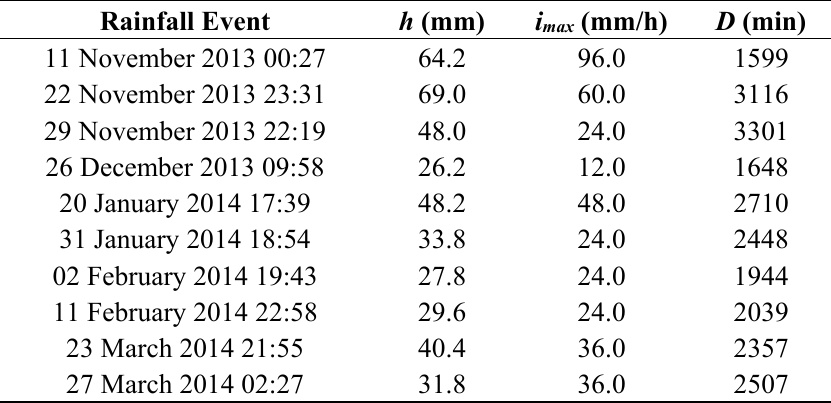
Table 3. Hydrologic characteristics of the selected rainfall events.